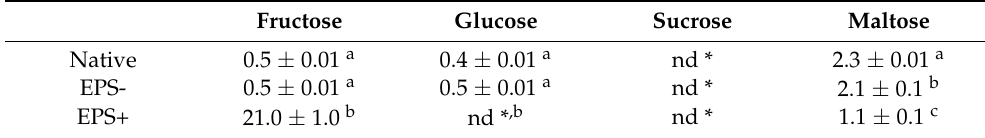
Table 3. Consumption and release of sugars during fermentation of BSG with W. confusa A16. Amount of sugars (% dry weight of fermented BSG) quantified before (native) and after fermentation of BSG with W. confusa A16 with (EPS+) and without (EPS-) addition of sucrose. Fructose Glucose Sucrose Maltose Native 0.5 ± 0.01